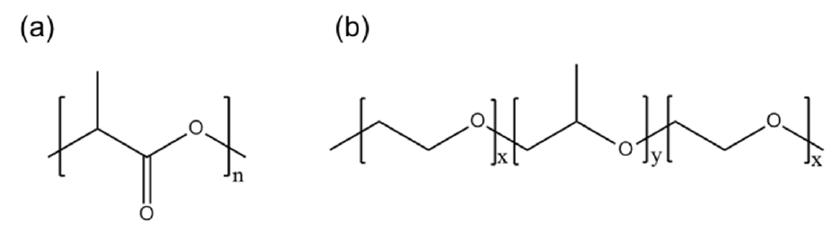
Figure 1. Chemical structures of ( a ) PLA and ( b ) PEG-PPG-PEG.